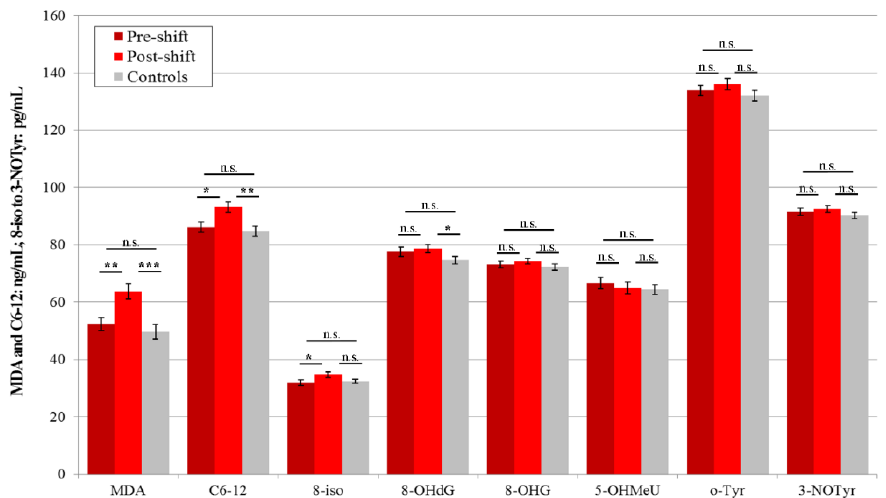
Figure 3. Mean and standard deviation of eight oxidative stress markers in the plasma of 20 workers (shift = machining) and 20 control subjects (morning) in 2017, * p < 0.05, ** p < 0.01, *** p < 0.001, n.s. = not significantly di ff erent, MDA = malondialdehyde, C6-12 = aldehydes C6-C12, 8-iso = 8- iso -prostaglandin F2 α (8-isoprostane), 8-OHdG = 8-hydroxy-2-deoxyguanosine, 8-OHG = 8-hydroxyguanosine, 5-OHMeU = 5-hydroxymethyl uracil, o-Tyr = o -tyrosine, 3-NOTyr = 3-nitrotyrosine.